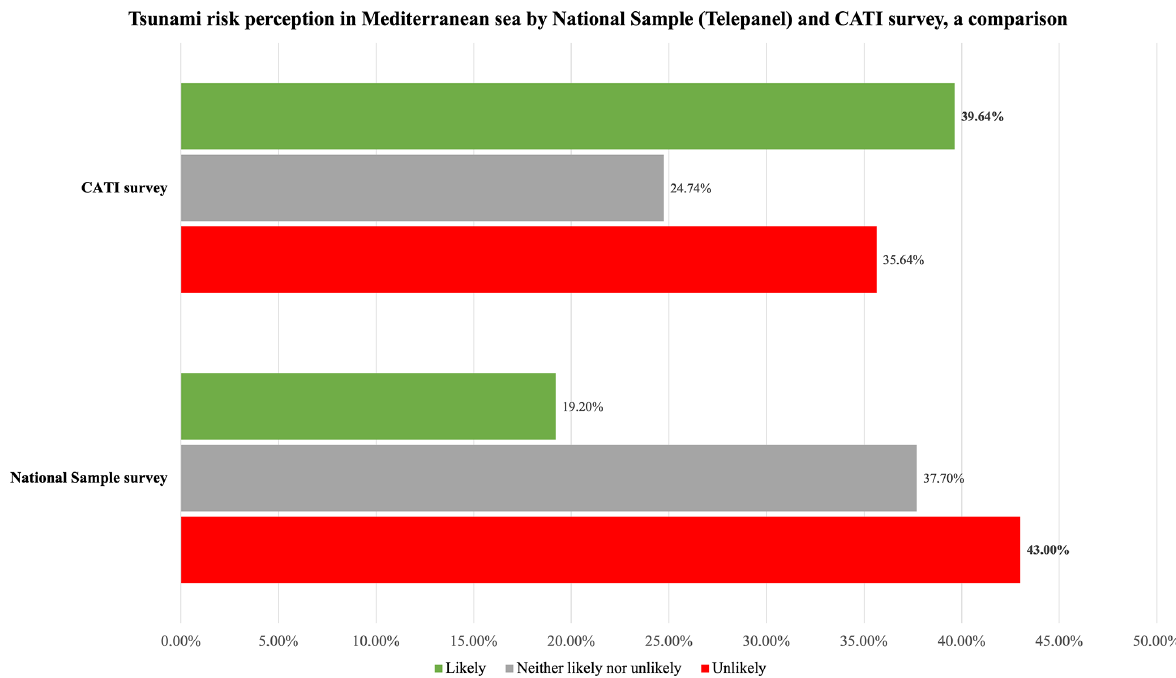
Figure 13. Tsunami risk perception in Mediterranean Sea by the national sample and CATI surveys, a